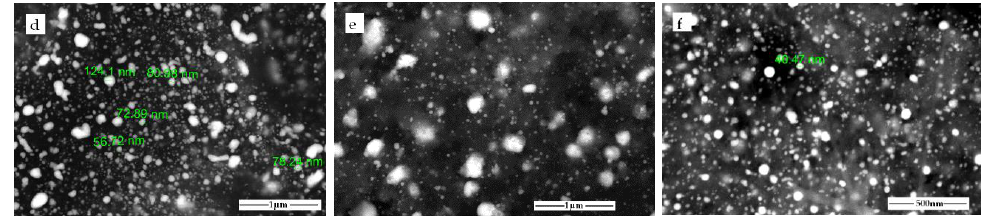
Figure 3. Scanning electron microscopy (SEM) photographs of α-Fe/Fe 3 C/woodceramic nanocomposites ( a ) WCM-0.1; ( b ) WCM-0.2; ( c ) WCM-0.3; ( d ) WCM-0.6; ( e ) WCM-1.0; and ( f ) WCM-0.2 with higher magnification.